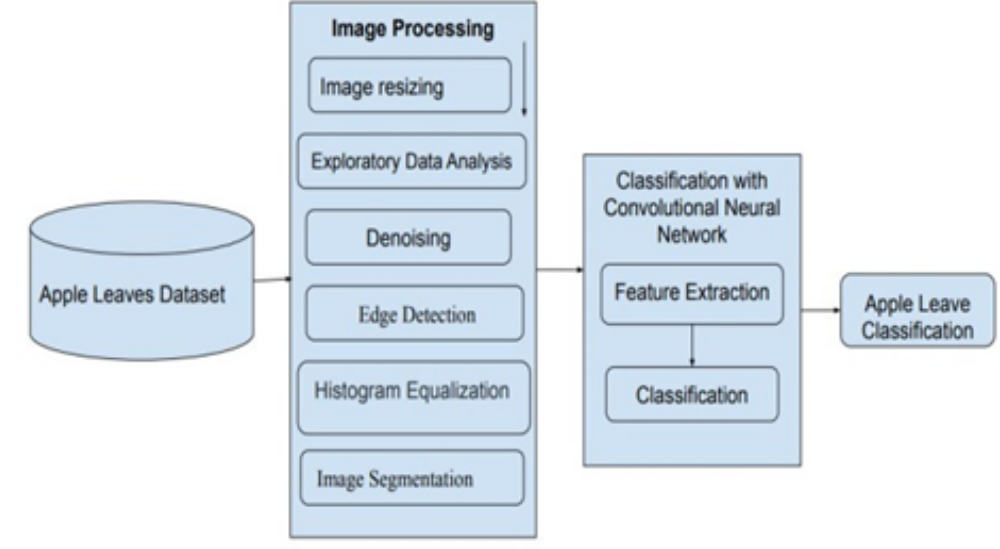
Figure 1. The Proposed